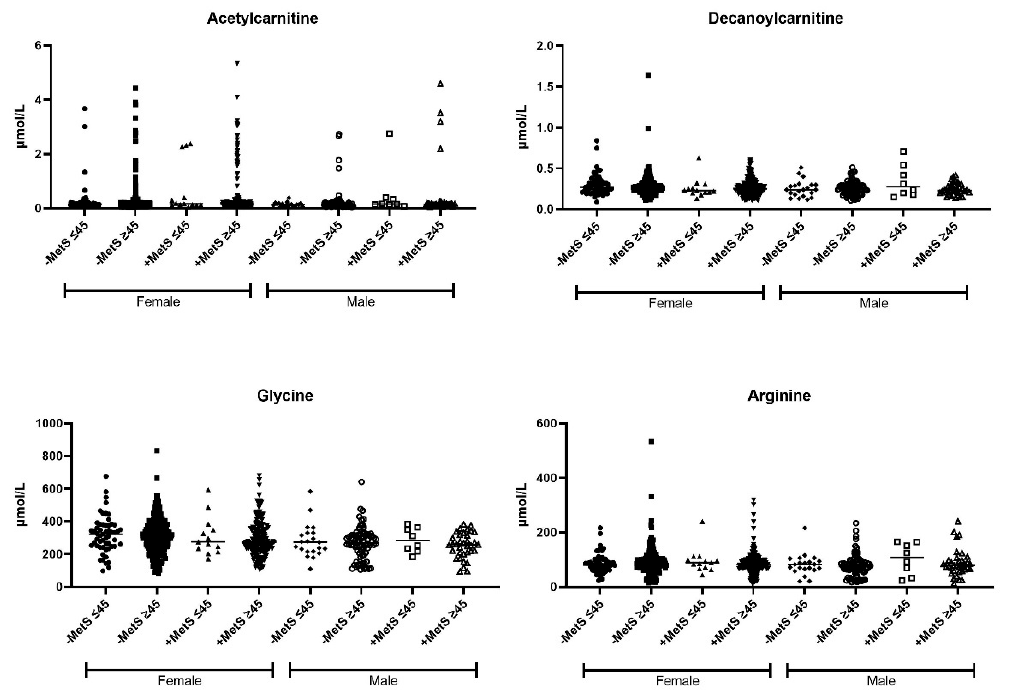
Figure A2. Serum concentration of acetylcarnitine, decanoylcarnitine, glycine, and arginine according to MetS, sex, and age.